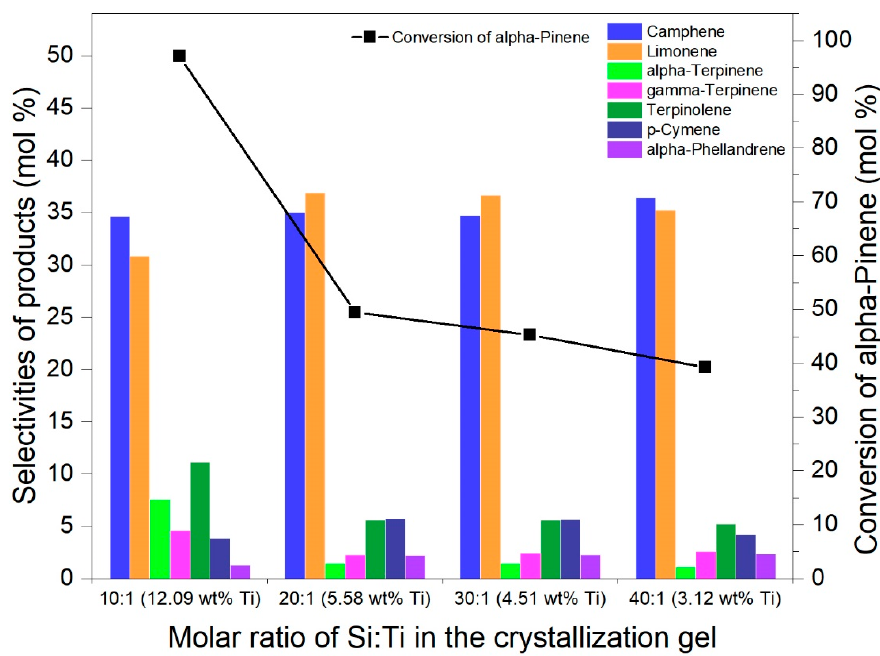
Figure 9. The influence of the molar ratio of Si:Ti in the crystallization gel on the conversion of α -pinene and on the selectivities of the appropriate products (temperature 160 ◦ C, catalyst content 7.5 wt%, and reaction time 6 h).